Question: Which visualization type does this figure use?
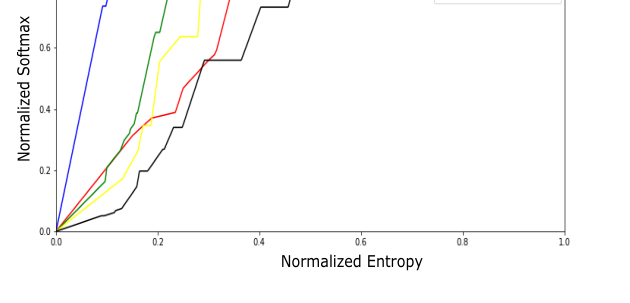
Answer: line